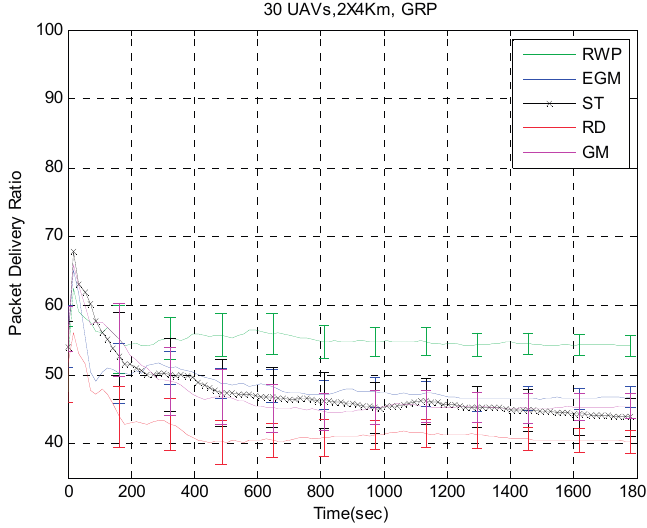
Figure 11. PDR of the geographic routing protocol (GRP) under various mobility